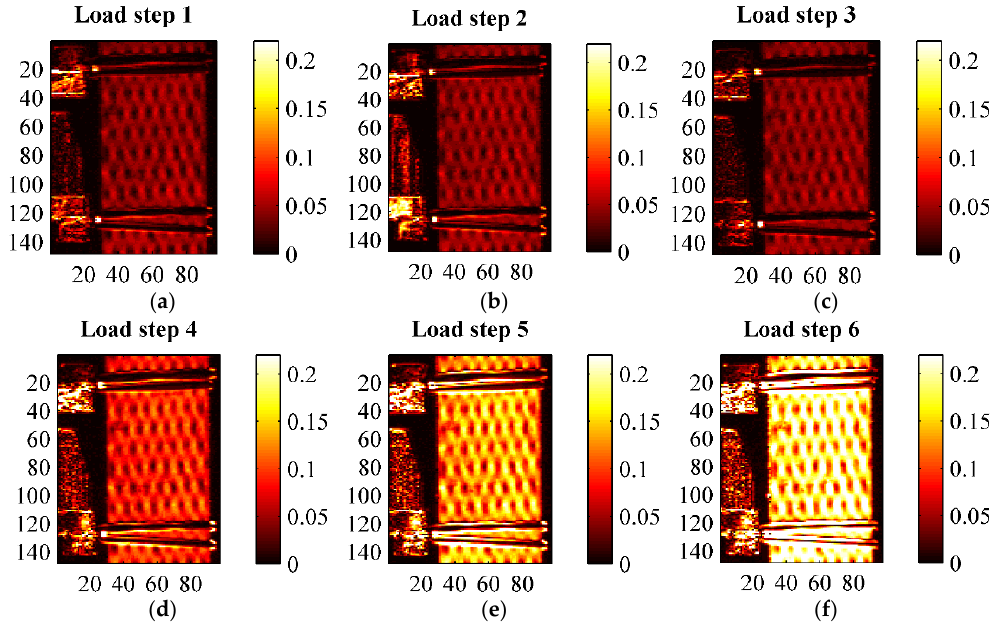
Figure 12. Thermoelastic signal amplitude Δ T in (°C) from an HL sample at the various loading steps. ( a ) load step 1; ( b ) load step 2; ( c ) load step 3; ( d ) load step 4; ( e ) load step 5; ( f ) load step 6.